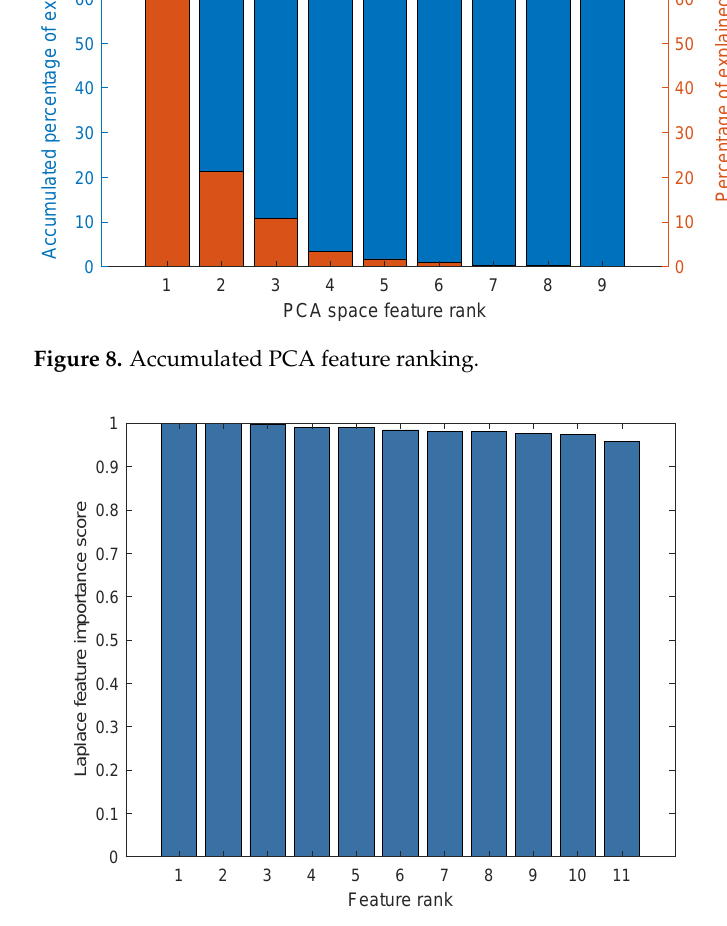
Figure 9. Laplacian score-based feature ranking The results of utilising different groups of features were compared. Figure 10 shows an example of the anomaly scores for a test case with no squat with different feature groups. The anomaly scores using PCA space features and the Laplacian score-selected features are shifted down with 0.5 and 1 correspondingly for better visualisation. The numerical comparison using mean root squared error (MRSE) is presented in Table 3. The anomaly scores generated by using all features and the PCA space features are very similar. This can be explained because the selected 5 PCA space features explain 96.55% of the variance of all features combined. The anomaly scores generated by using Laplacian score-selected features and the PCA space features are also very similar. This shows both feature selection approaches generate similar anomaly scores and are acceptable. However, the anomaly scores generated by using all features and the Laplacian score-selected features are slightly more different with around double MRSE values. The Laplacian score approach only removed five redundant features that are highly correlated with the selected most important features and the anomaly score difference is still small. Plotting and comparing the anomaly scores for those two cases verifies that the difference is so small that it is reasonable to assume similar